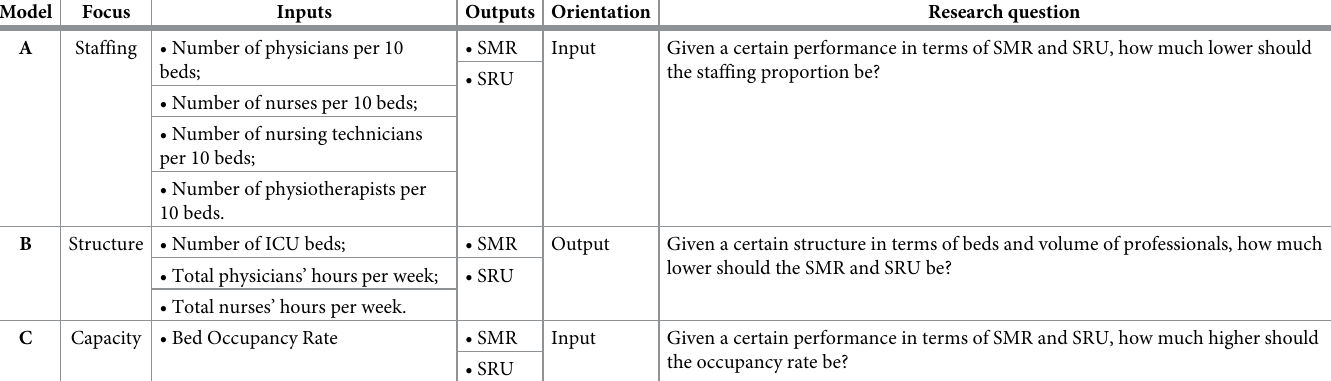
Table 1. Specifications of the DEA